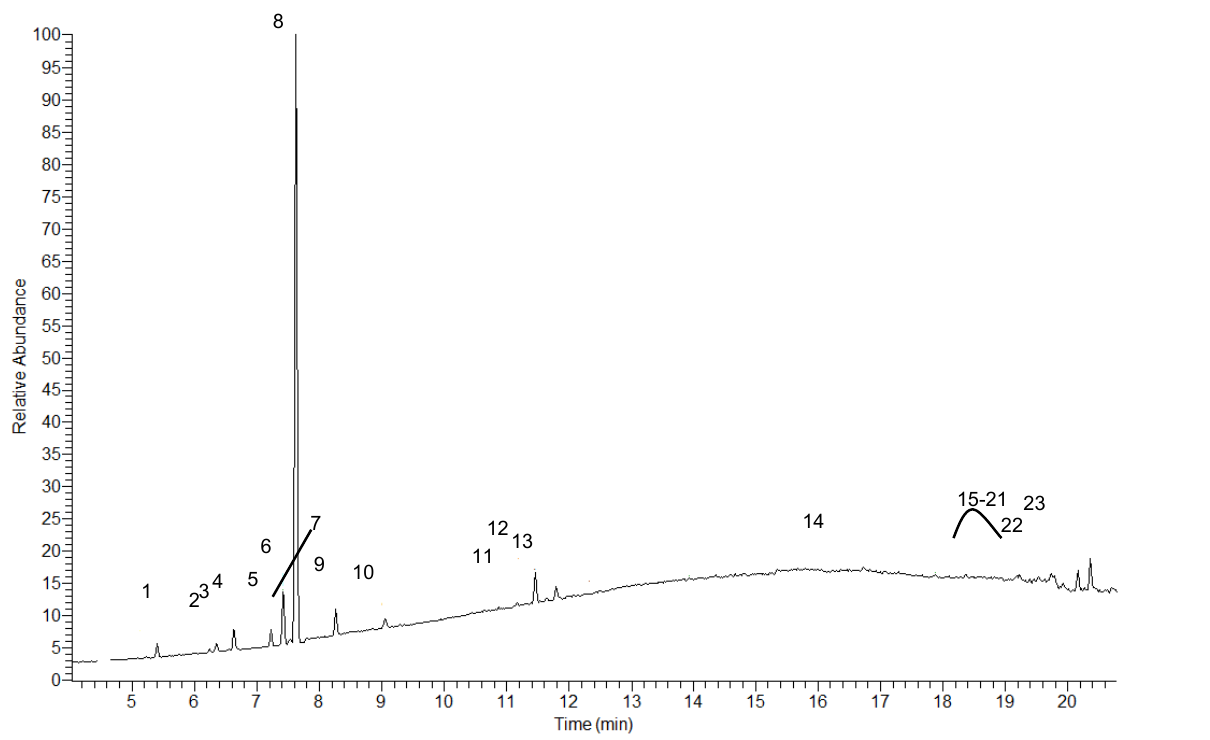
Figure 1. Chromatograms GC-MS of H. gymnocephalum essential oil (1: α -thujene;